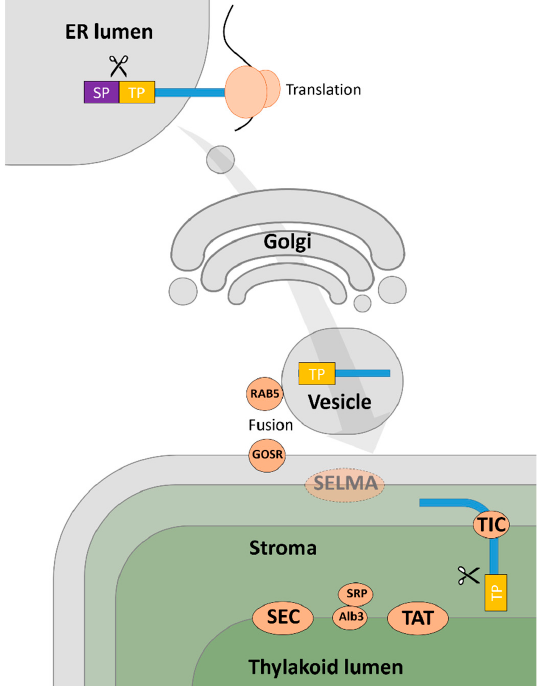
Figure 1. Protein transport into the secondary chloroplast of Euglena . Nuclear encoded chloroplast pre-proteins (blue strip) are synthesised into the lumen of the endoplasmic reticulum (ER) where the signal peptide (SP) is cleaved. Pre-proteins with transit peptides (TP) are subsequently transferred to the outermost chloroplast membrane through the Golgi body via vesicles. GOSR and RAB5 GTPase are proposed to mediate the fusion of the vesicle to the outermost membrane. After transport of proteins into the stroma, where the TP is removed, the mature protein can enter the thylakoid lumen via SEC, TAT, or Alb3 / SRP pathway. This scheme only considers proteins possessing Class I and II targeting signals, as the transport of those with unclassified signals is not known